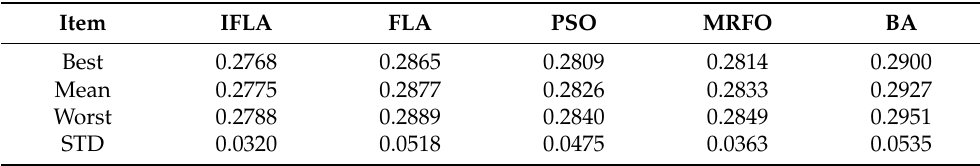
Table 6. The performance comparison of different algorithms using the statistic analysis without storage degradation